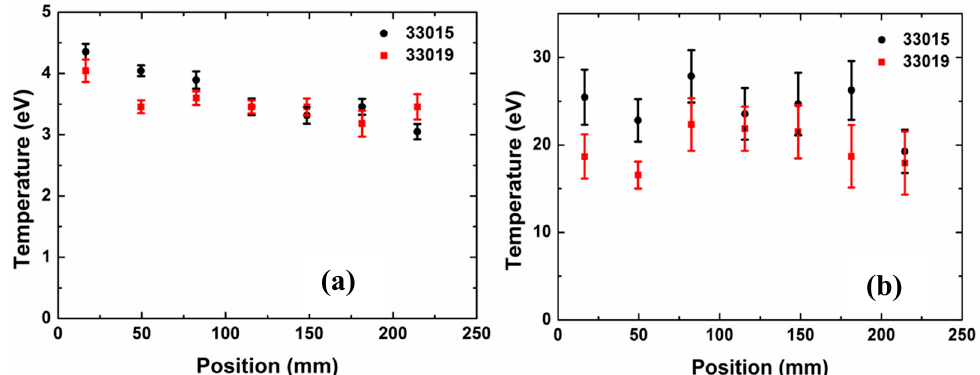
Figure 6. The spatial profile of temperature of the ( a ) warm and ( b ) hot components of the neutral hydrogen atom for shot #33,019 and #33,015.